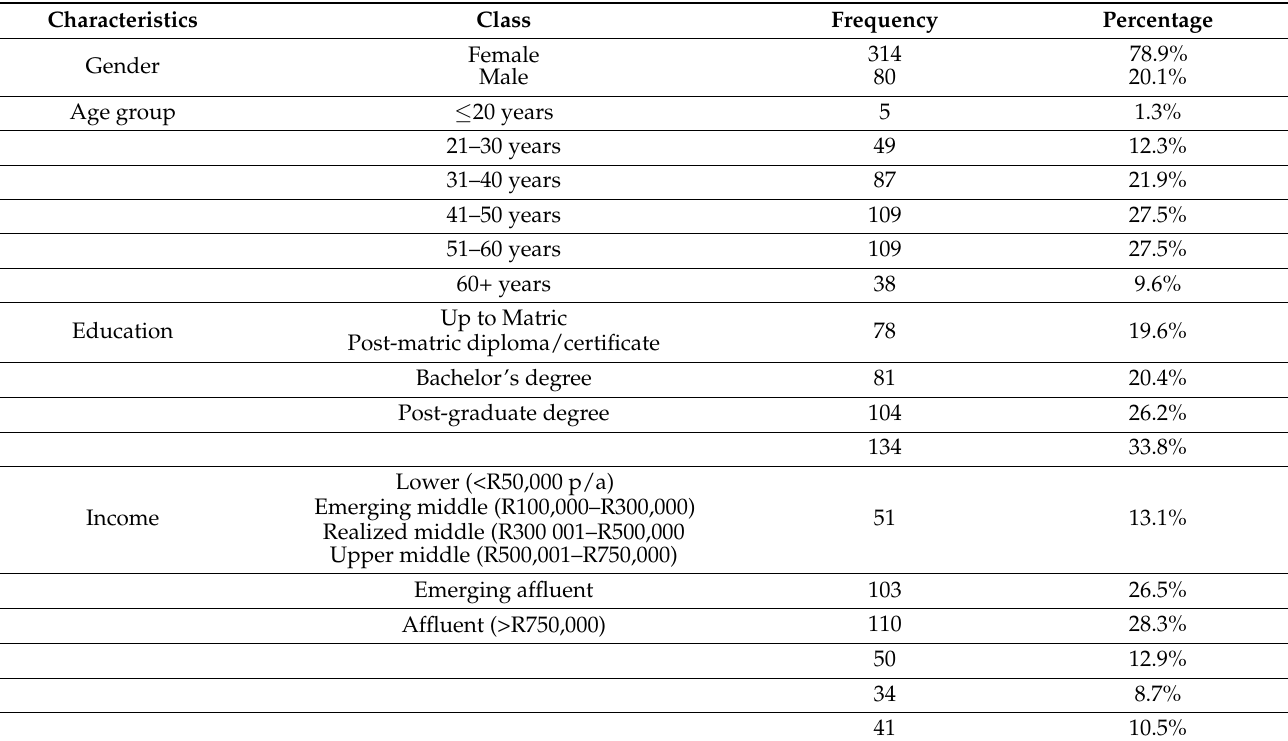
Table 2. Socio-demographical attributes of respondents.